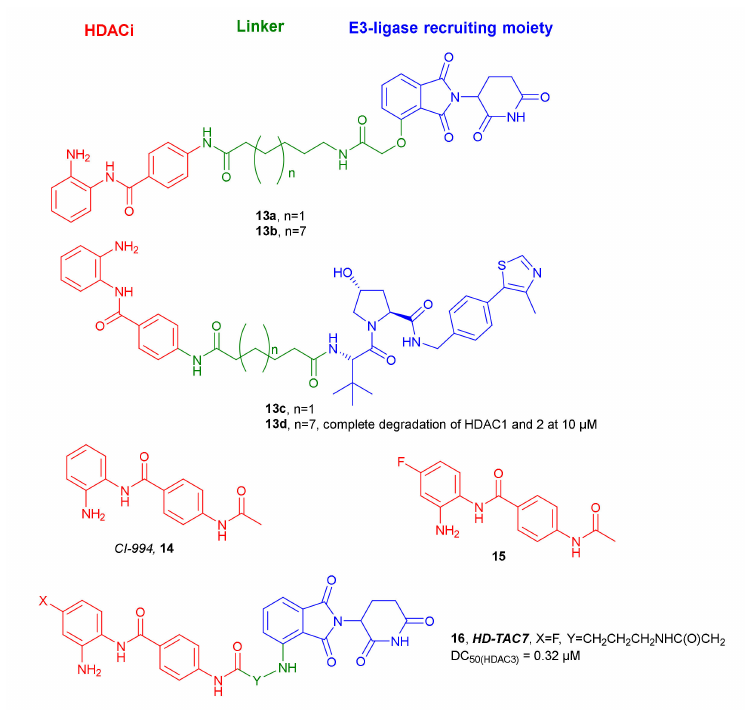
Figure 8. General structures of compounds 13 – 16